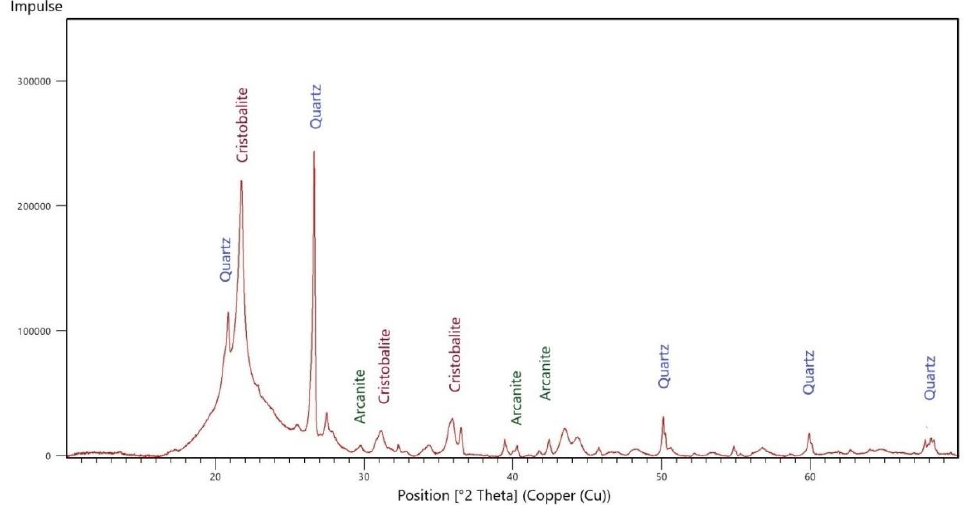
Figure 7. X-ray diffraction (XRD) analysis of the coherent ash particle from the experiment in the 100 kW DFB gasification pilot plant.